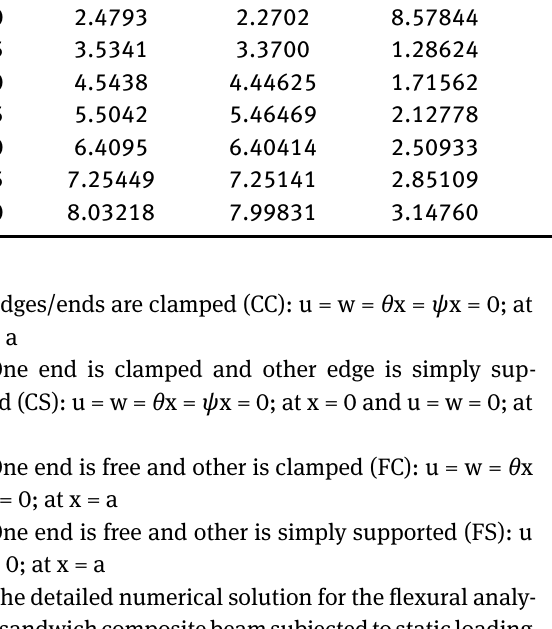
Table 1: Effect of SWCNT volume fraction on mechanical property of SWCNTR sandwich composite beam V